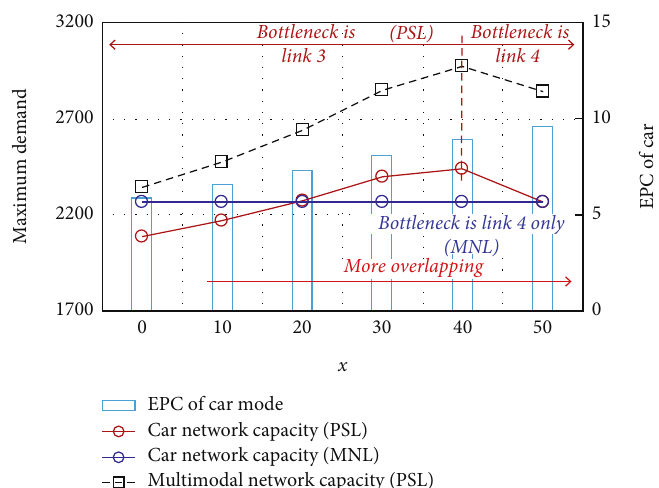
Figure 9: E ff ect of route overlapping on network